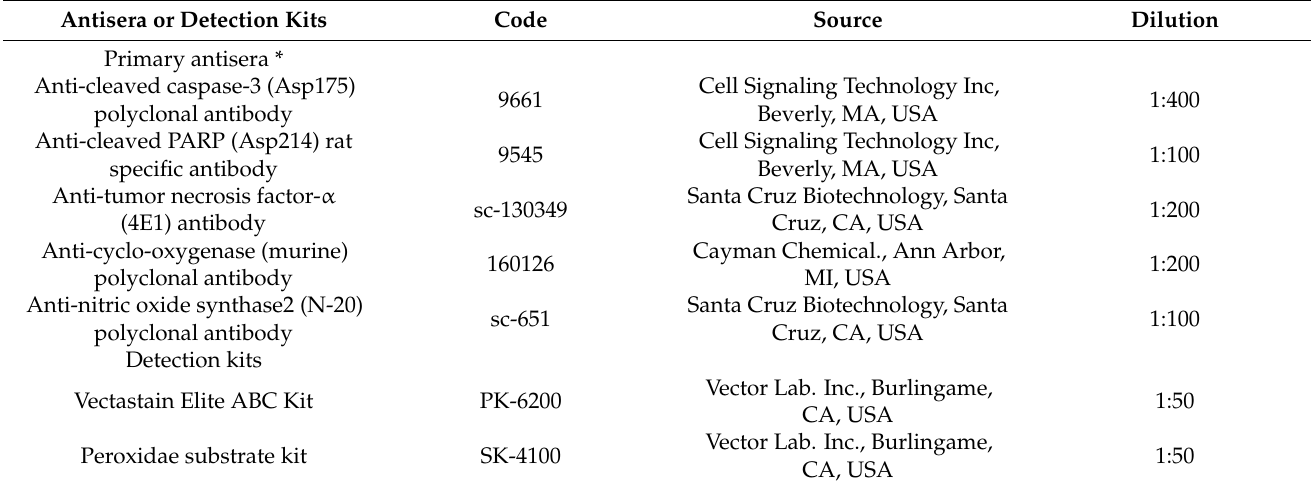
Table A1. Primary antisera and detection kits used in this